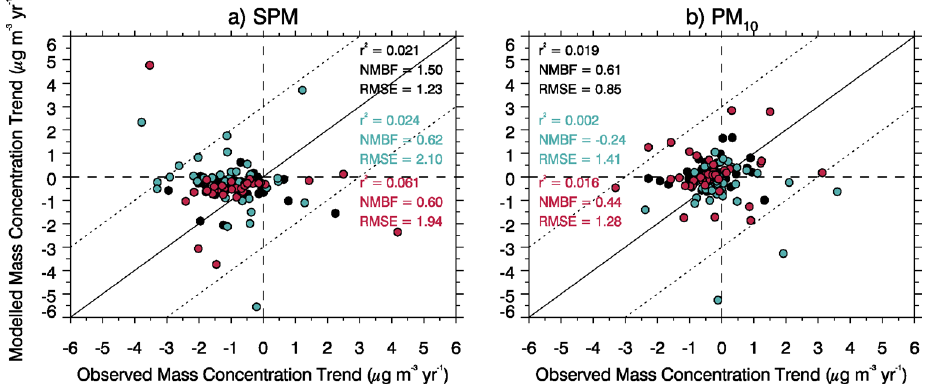
Figure 10. Calculated annual (black), summertime (red) and wintertime (blue) linear trends in modelled and observed (a) SPM and (b) PM 10 mass concentrations (µgSm − 3 yr − 1 ) at each individual monitoring location over their operational period between 1978 and 2002 for SPM and between 1996 and 2009 for PM 10